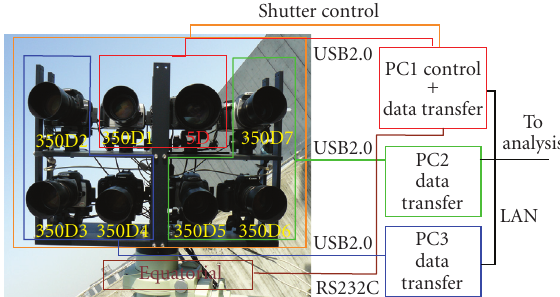
Figure 2: The schematic of AROMA-W system. Each camera and the equatorial mount are controlled by PC1. The observational data are acquired individually by the three PCs and forwarded to an analysis machine through LAN.